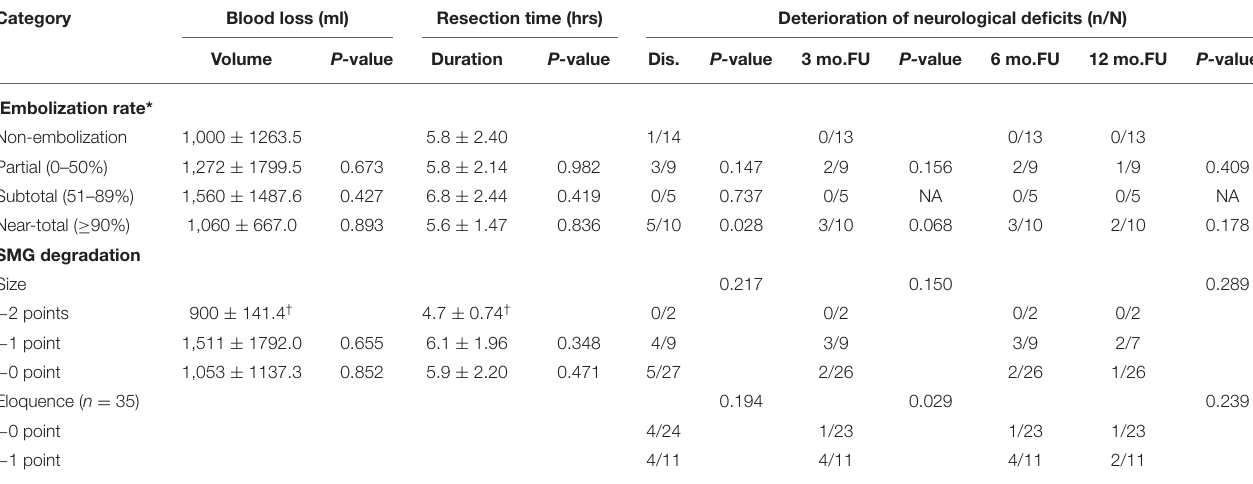
TABLE 3 | Subgroup comparisons in different embolization rates and SMG degrading strategies. Category Blood loss (ml) Resection time